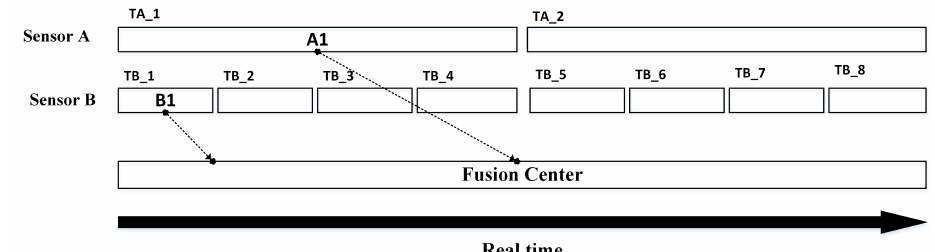
Figure 1. Out-of-sequence measurements (OOSMs) Scenario with different measurement arrival